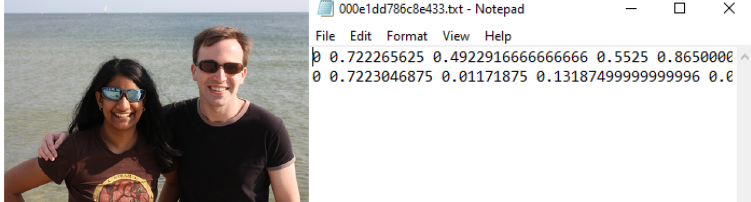
Fig. 1 Examples of data used in